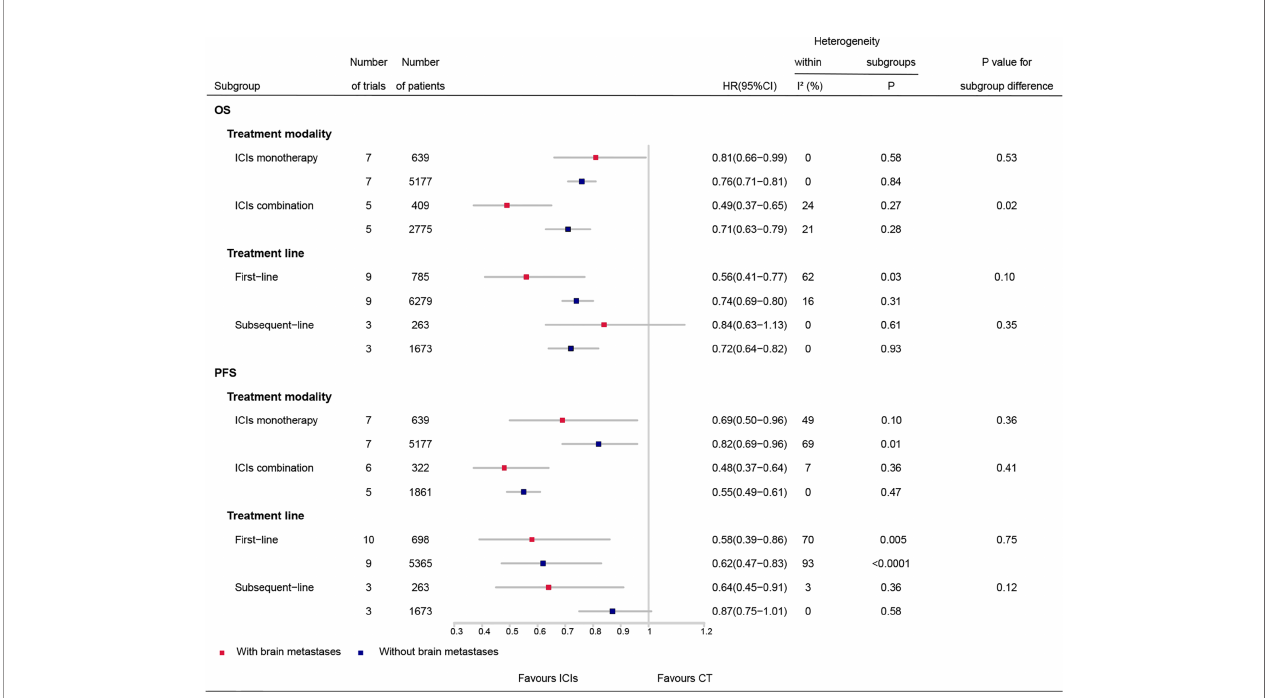
FIGURE 3 | Comparison of ICIs ef fi cacy between patients with and without brain metastases by subgroups. OS, overall survival; PFS, progression-free survival; ICIs, immune checkpoint inhibitors; CT, chemotherapy; HR, hazard ratio; CI, con fi dence